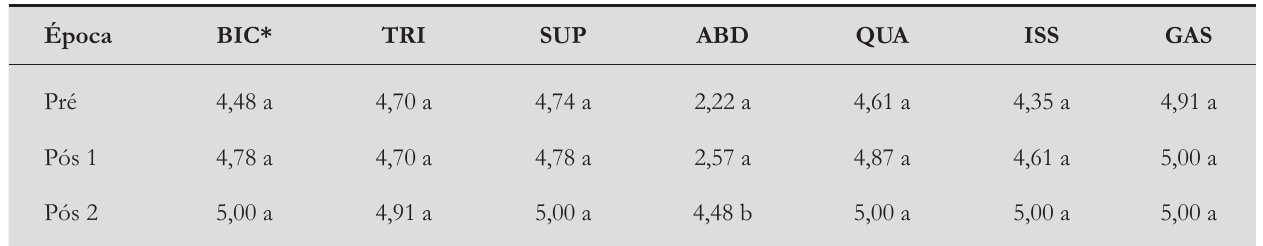
Tabela 1 - Média de forças e diferenças obtidas pelo teste de comparações múltiplas associado ao teste de Friedman em todos os músculos